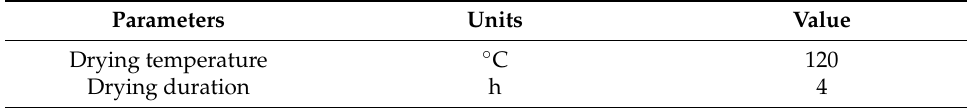
Table A2. Drying conditions of injected materials.